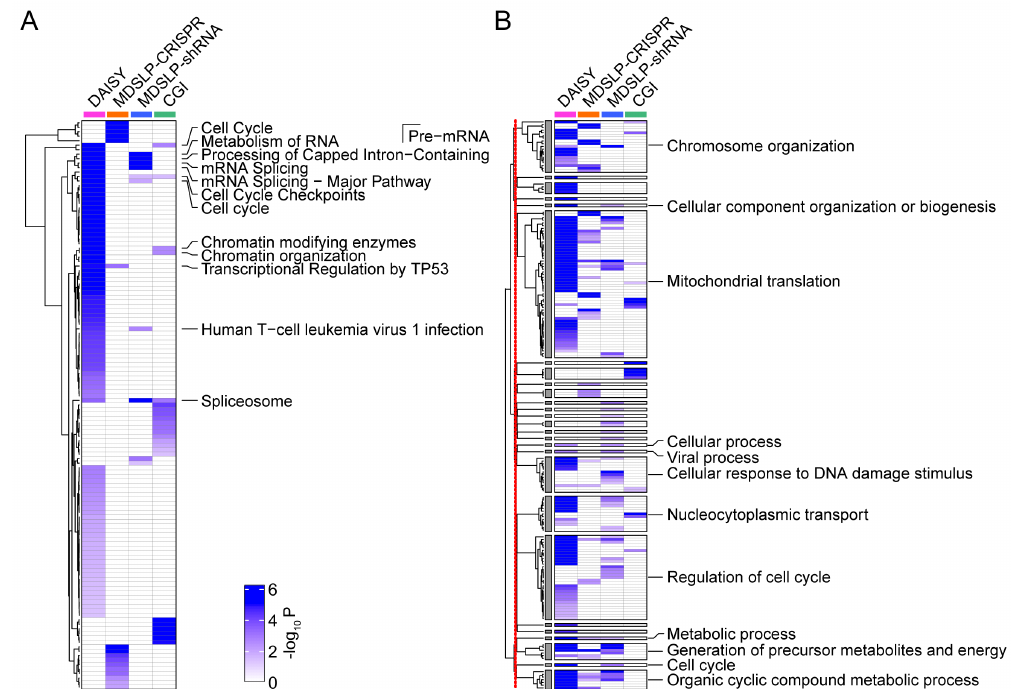
Figure 4. Pathway enrichment of predicted synthetic lethal partners of DNA damage repair (DDR) genes. Heatmaps depicting A. the KEGG or REACTOME pathway and B. Gene Ontology Biological Process (GOBP) enrichment for predictions made using four different approaches (columns). Increasing color intensity represents increasing statistical significance ( P < 0.05, calculated by a hypergeometric test) for enrichment. Pathways or GOBPs were labeled if they were enriched by synthetic lethal partner genes identified by at least two prediction approaches. The redundant GOBPs were further reduced by REVIGO. The 398 GOBPs enriched by at least one approach were reduced to 172 GOBPs based on their semantic similarities, and then summarized into 27 representative groups whose enrichment significance is represented in the heatmap. Clustering analysis was performed for GOBPs inside and outside of the 27 representative groups, separately. The red line down the left side of panel B indicates the separation between the clustering analyses. DAISY, data mining synthetic